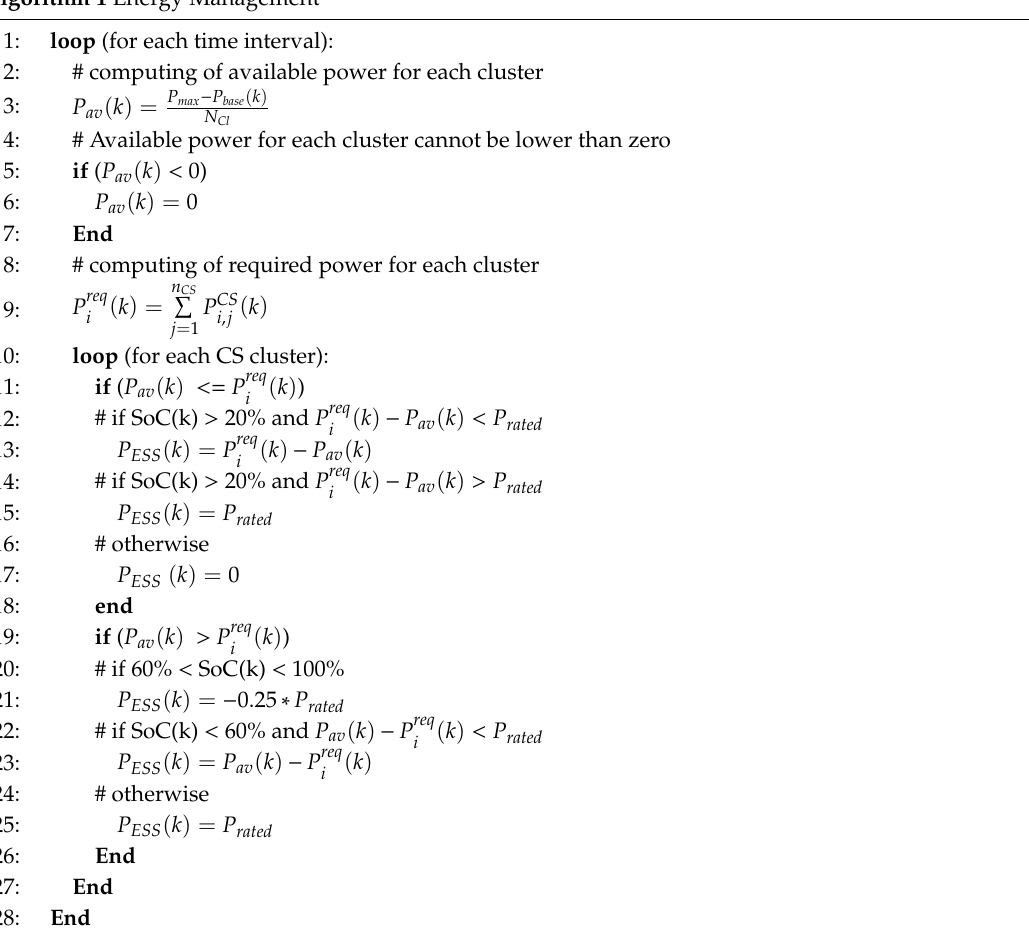
Algorithm 1 Energy